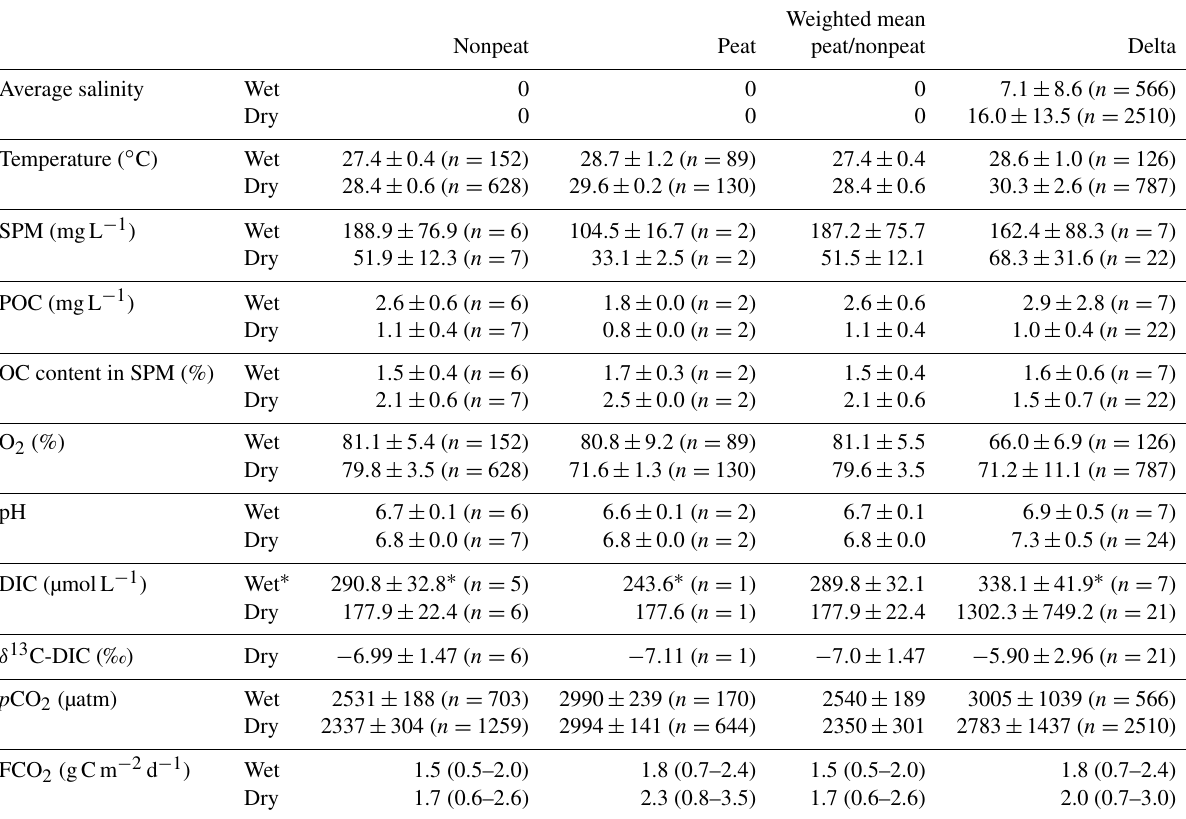
Table 2. Average values of measured parameters for different river reaches (mean ± 1SE) for all parameters except FCO 2 , which is reported as mean (minimum −